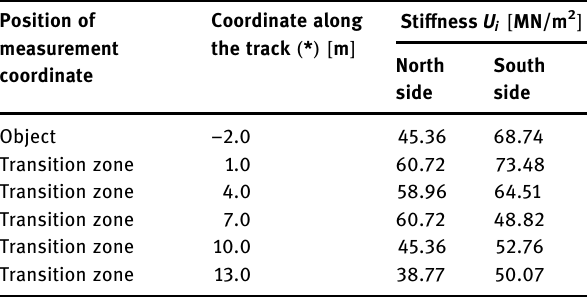
Table 2: Variability of rail foundation sti ff ness along the